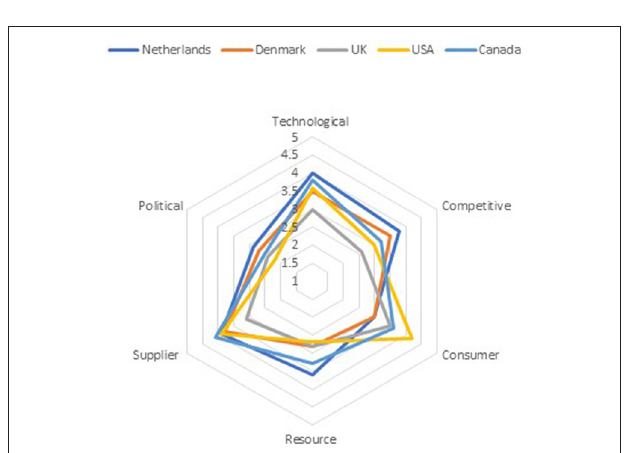
FIGURE 4 | Average factor scores for the six uncertainties across countries (scale of 1–5 where 1 = strongly disagree, 5 = strongly agree).